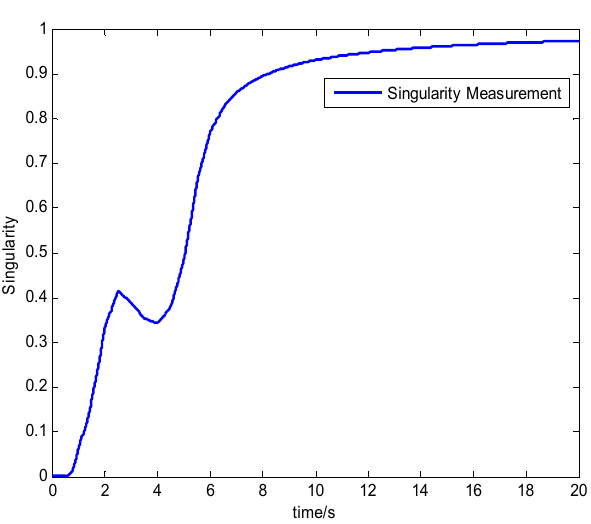
Figure 13. Singularity measurement